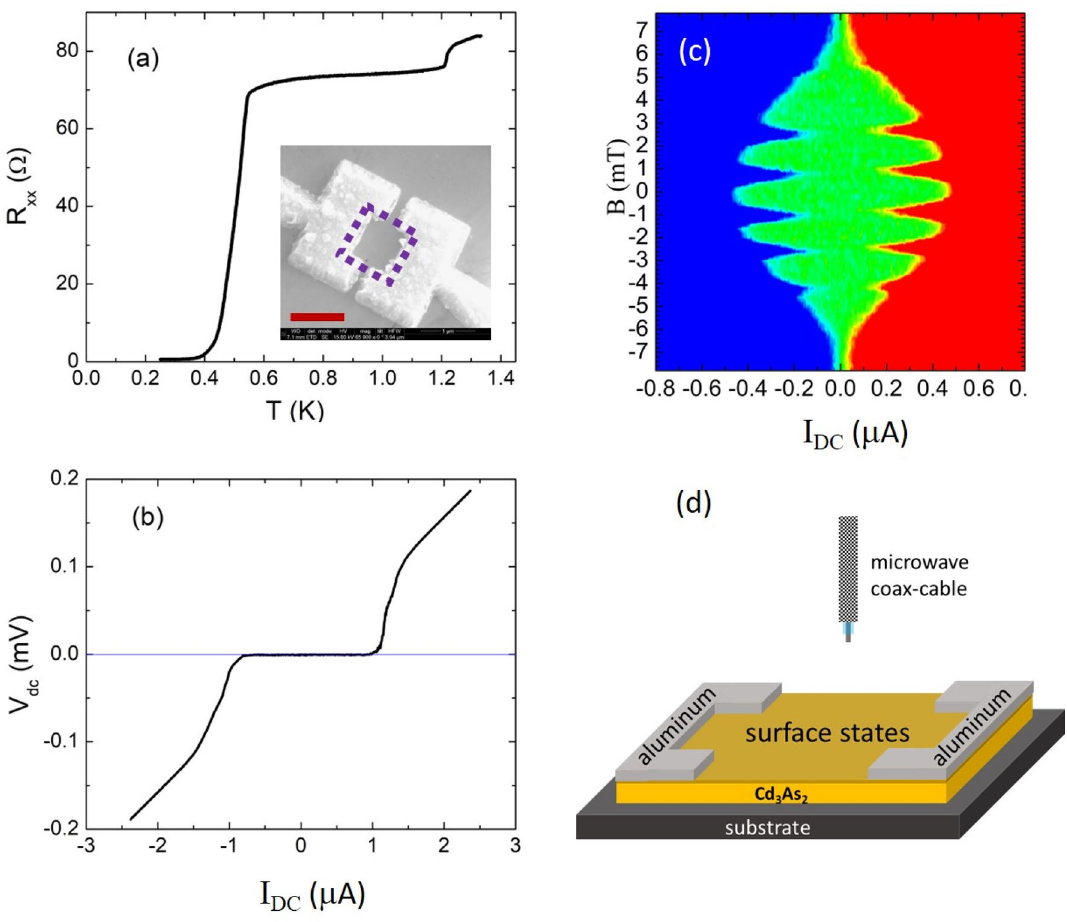
Figure 1. ( a ) The temperature dependence of the junction resistance in a superconducting quantum interference device (SQUID). The insert shows the SQUID device fabricated on a Cd 3 As 2 thin flake. The scale bar is 1 µm. ( b ) The current–voltage (I–V) curve measured in the SQUID. The critical current is ~ 1 µA. ( c ) The two-dimensional color plot of I–V traces as a function of magnetic fields at 0.44 K. The red color represents a positive V dc , blue for negative V dc . The green area represents the supercurrent regime. ( d ) The schematic setup (dimension not to scale) used to examine microwave